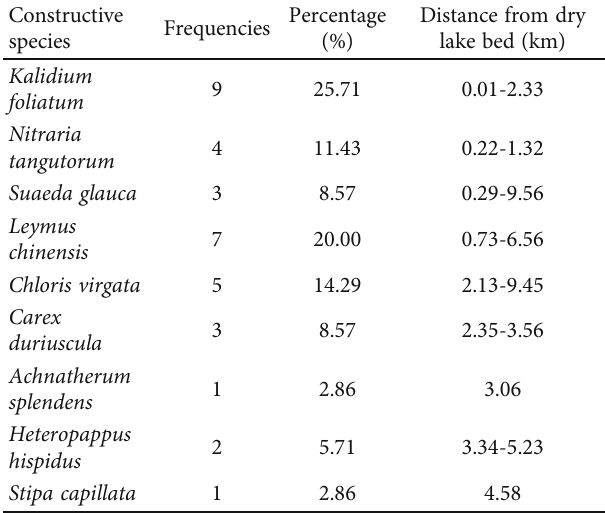
Table 1: Vegetation community characteristics.